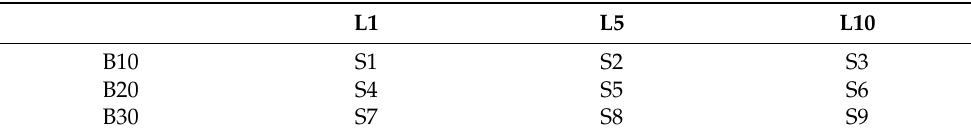
Figure 3. Fluctuation ranges of uncertain parameters. Table 4. Scenario